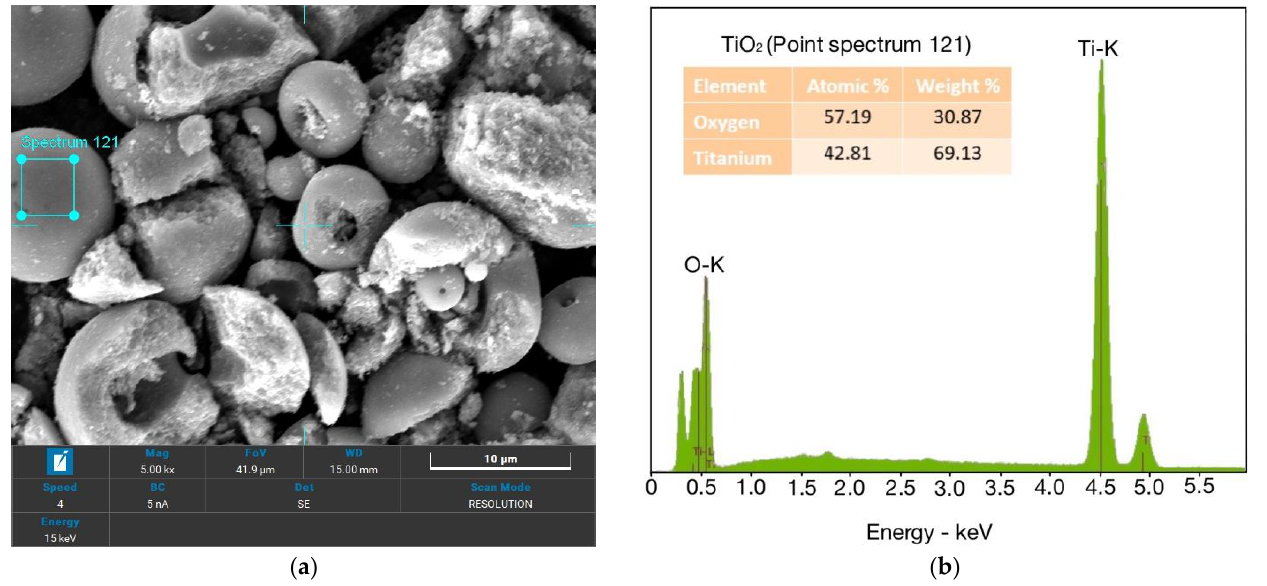
Figure 3. SEM nano-TiO 2 are as follows: ( a ) The morphology of nano-TiO 2 ; ( b ) The electron dispersive X-ray spectroscopy (EDS) result of nano-TiO 2 used in this work.